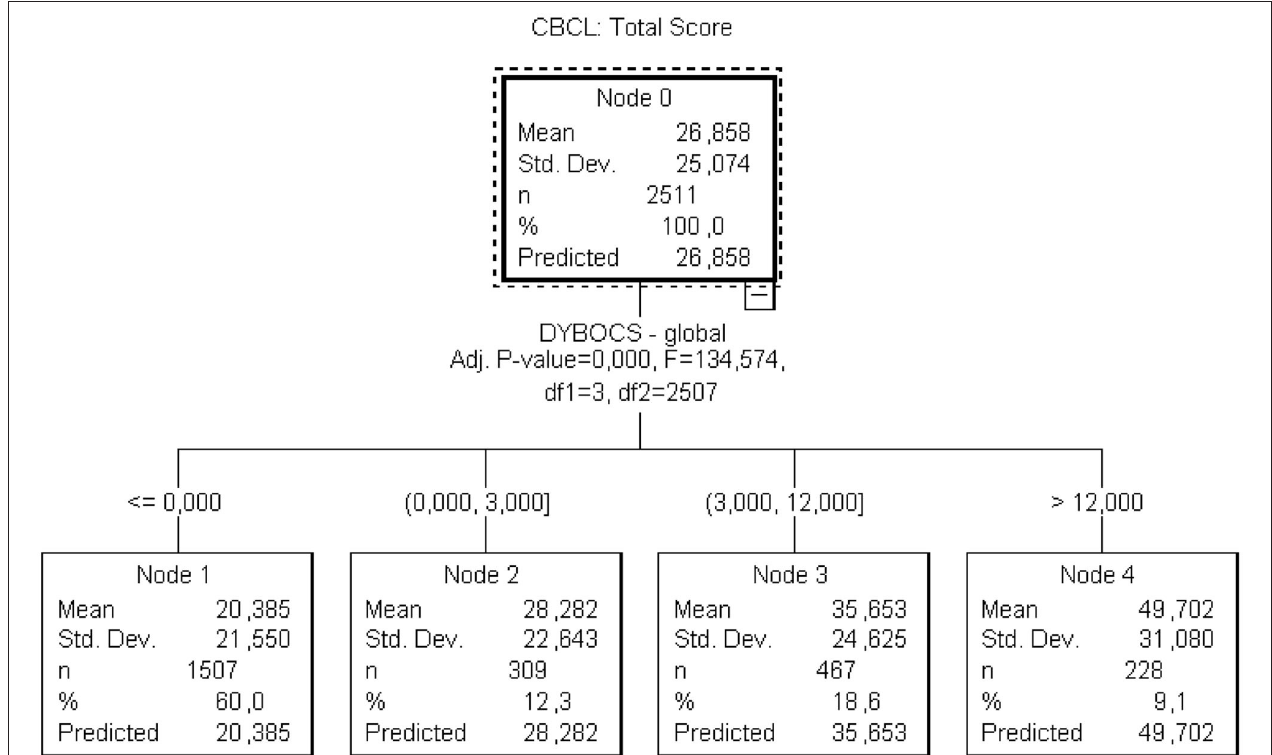
FIGURE 2 | Decision tree regarding maternal OCS global score and children’s overall psychopathology.